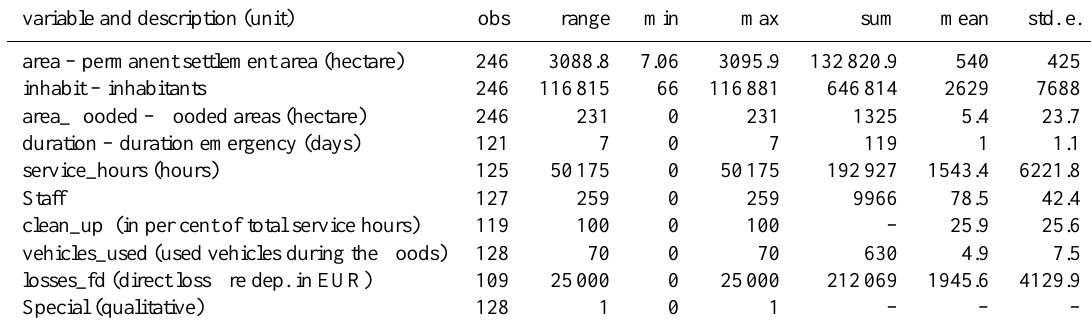
Table 5. Descriptive statistics of the variables used. variable and description (unit)